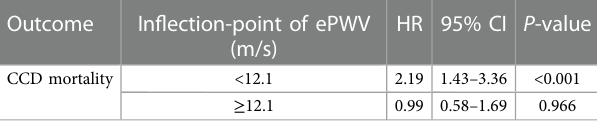
TABLE 3 The results of two-piecewise linear regression model for ePWV and the risk of all-cause and CCD mortality in stroke patients.